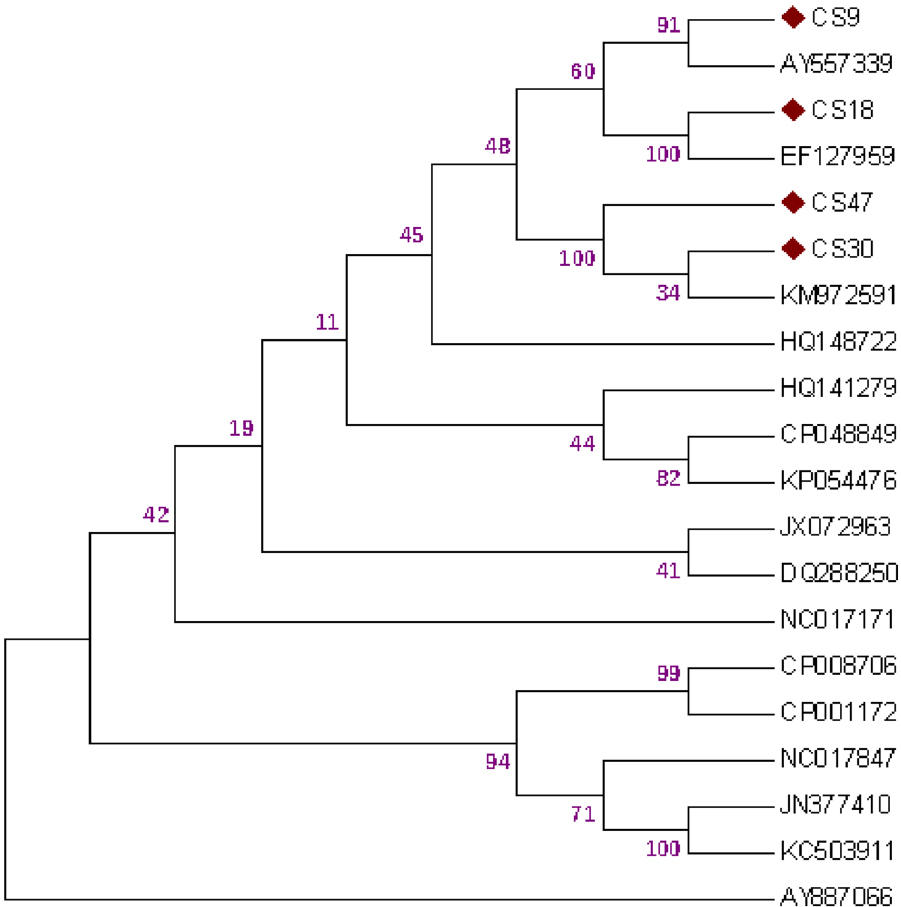
Figure 7. Phylogenetic tree for the strains of Acinetobacter based on the amino acid sequences of internal gene cassette by the neighbor-joining method.